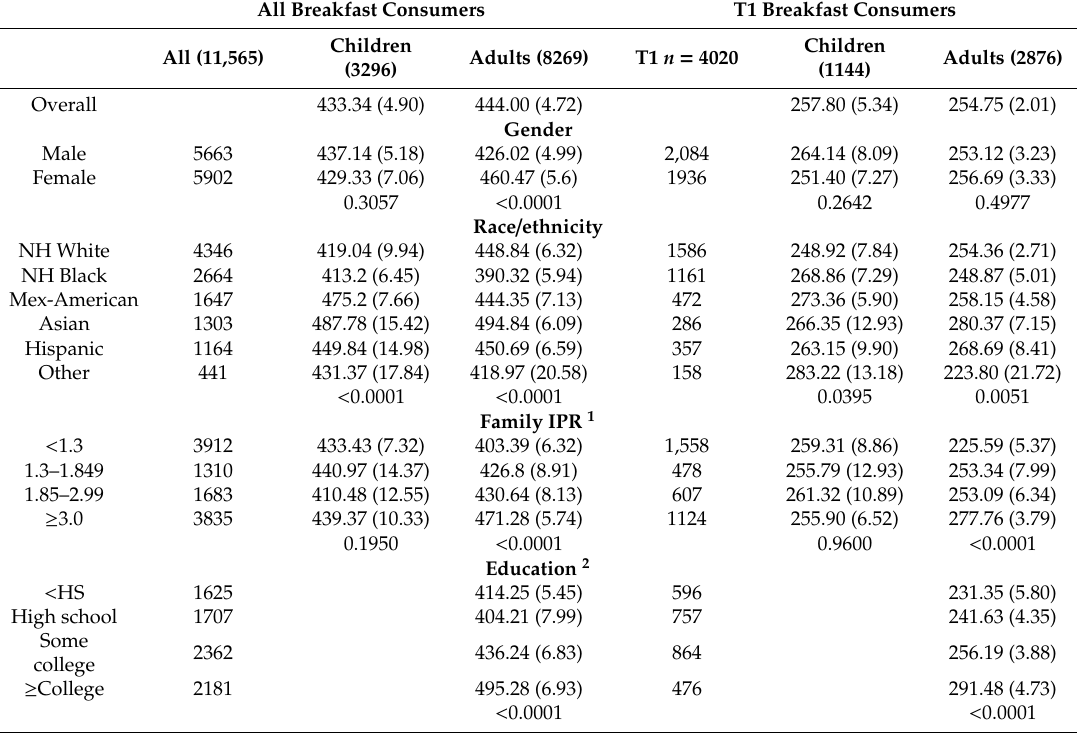
Table 1. Mean (standard error) dietary nutrient density NRF 9.3 scores for breakfast consumers by age and socio-demographics. NHANES 2011–2014, United States. (NH